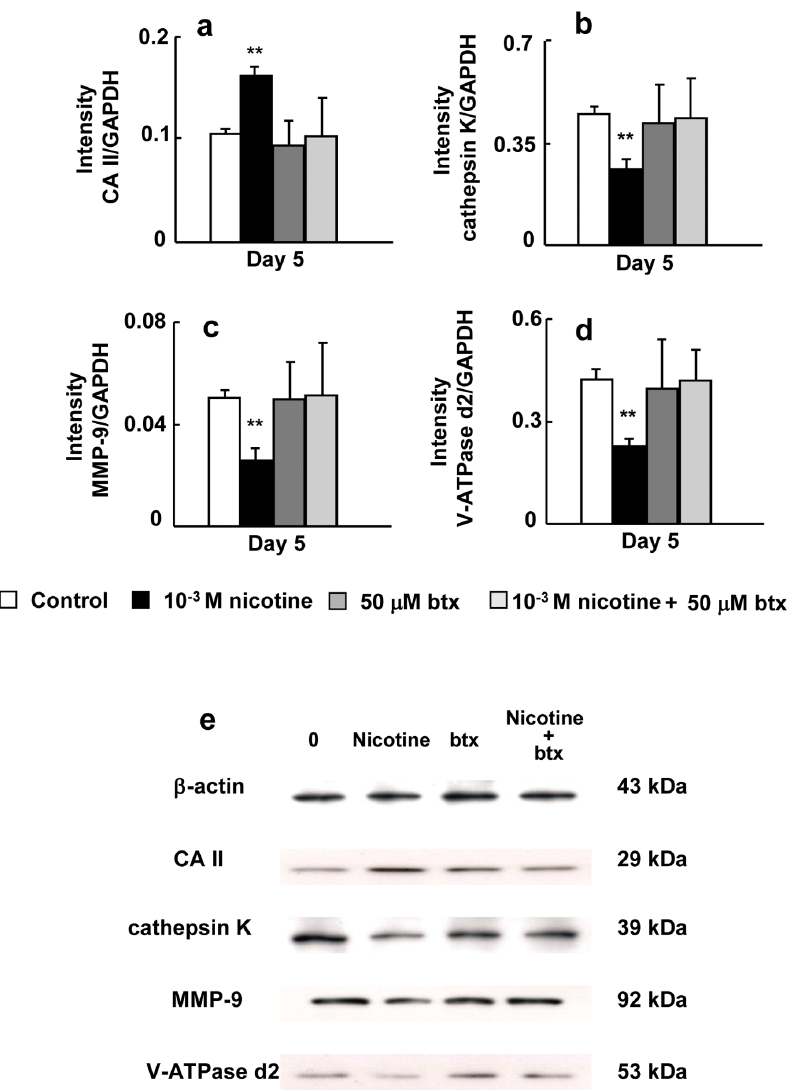
expression of CA II (a), cathepsin K (b), MMP-9 (c), and V-ATPase d2 (d) was determined by real-time PCR. Cells were cultured in differentiation medium without drug (control), 50 m M btx, 10 2 3 M nicotine, or 50 m M btx and 10 2 3 M nicotine for 5 days. The protein expression of CA II, cathepsin K, MMP-9, and V-ATPase d2 was determined by Western blotting (e). Data are shown as the mean 6 S.D., n=3 independent experiments. *p , 0.05, **p , 0.01, nicotine treatment vs.